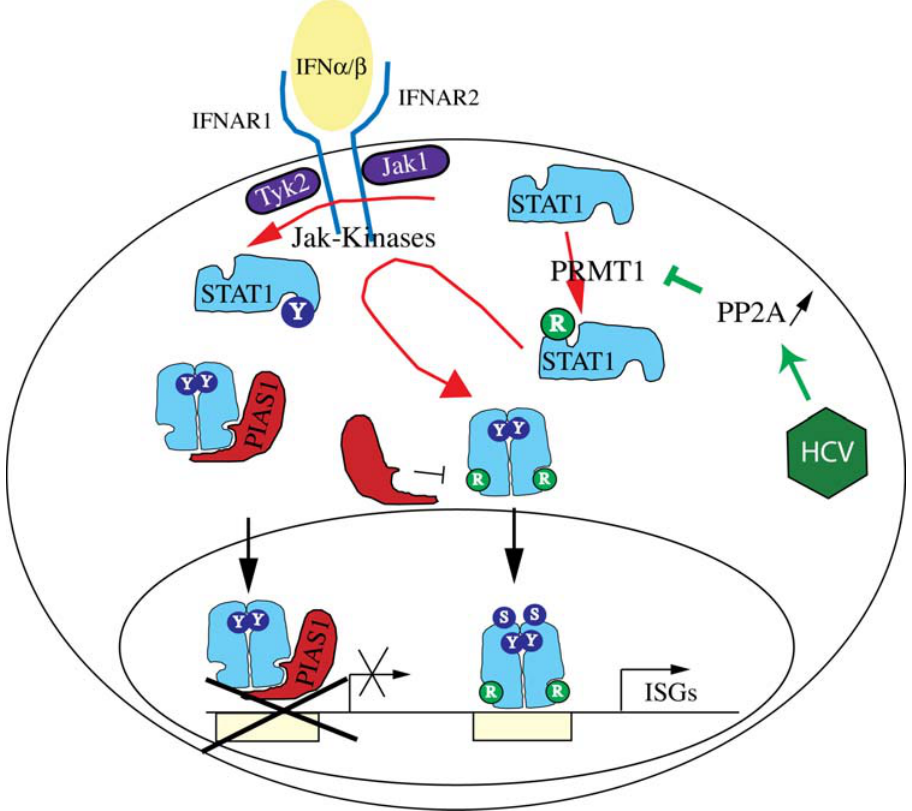
Figure 3. HCV induces the over-expression of PP2Ac via an ER stress response pathway. PP2A inhibits PRMT1, the enzyme responsible for STAT1 methylation. The resulting hypomethylation of STAT1 facilitates the binding of PIAS1, an inhibitor of DNA binding of activated STAT1. Tyrosine phosphorylation is shown by Y, and arginine methylation by